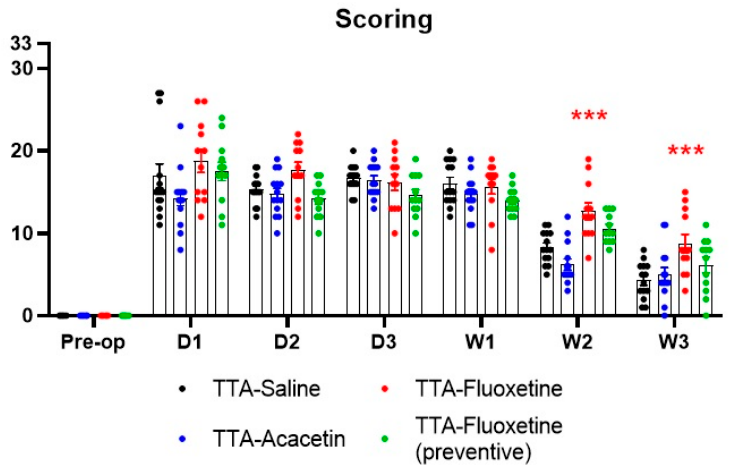
Figure 2. Time course of the vestibular syndrome evaluated through behavioural subjective scoring. Data represent mean ± SEM; statistically significant differences (*** p < 0.001) compared to control group, two-way ANOVA applies to all graphs. Significant differences between TTA–Saline and TTA–Fluoxetine groups are indicated by red stars.